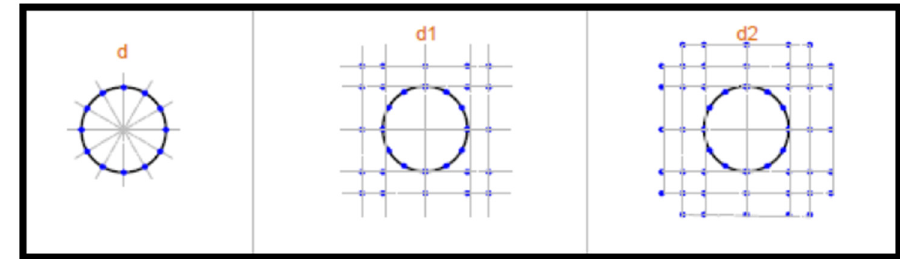
Figure 7: Grouting around the footing to a depth of d ′ .